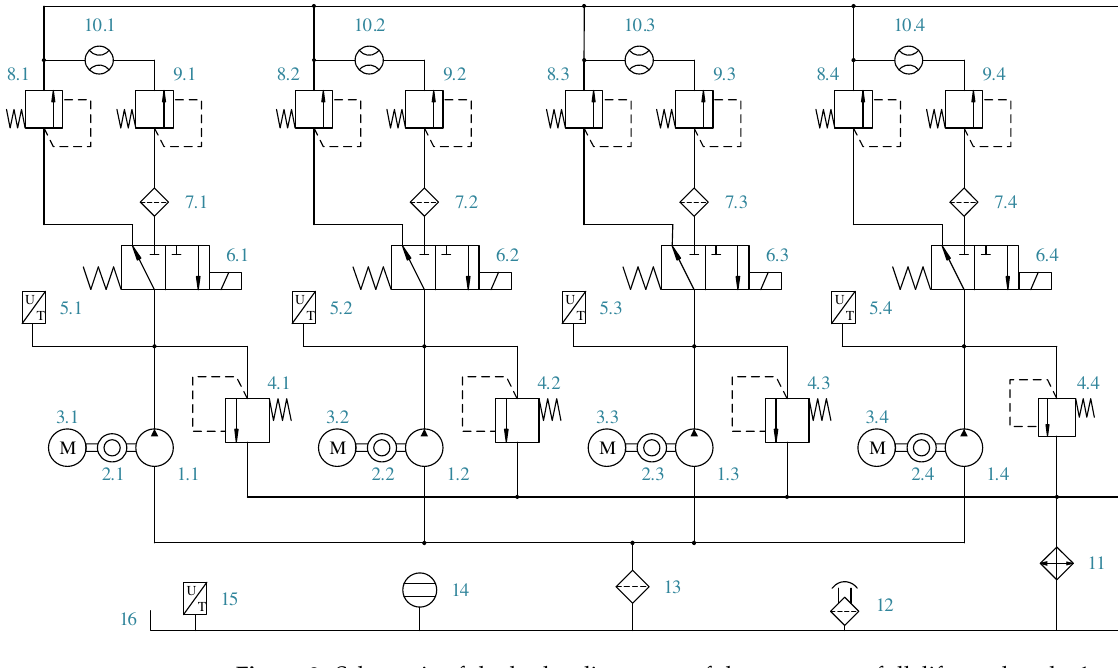
Figure 9. Schematic of the hydraulic system of the gear pump full–life test bench. 1, gear pump; 2, meter of rotating speed and torque; 3, electromotor; 4, relief valve; 5, pressure sensor; 6, solenoid directional valve; 7, high–pressure filter; 8, high–pressure relief valve; 9, low–pressure relief valve; 10, flow meter; 11, cooler; 12, air filter; 13, oil filter; 14, liquid level gauge; 15, temperature sensor; 16, tank. Table 1. Test bench components and their performance parameters.